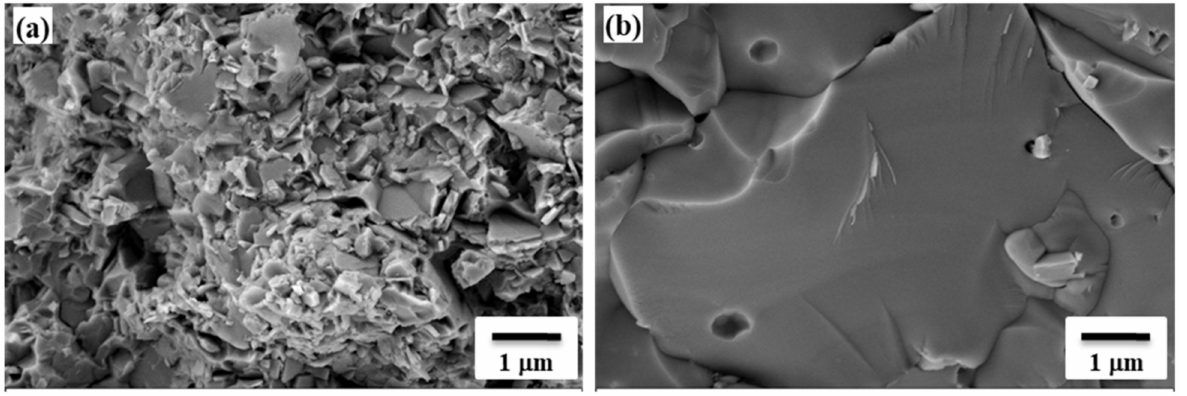
Figure 6. SEM images of fracture surface of SPS produced samples, ( a ) 3 min, ( b ) 10 min, T = 1200 ◦